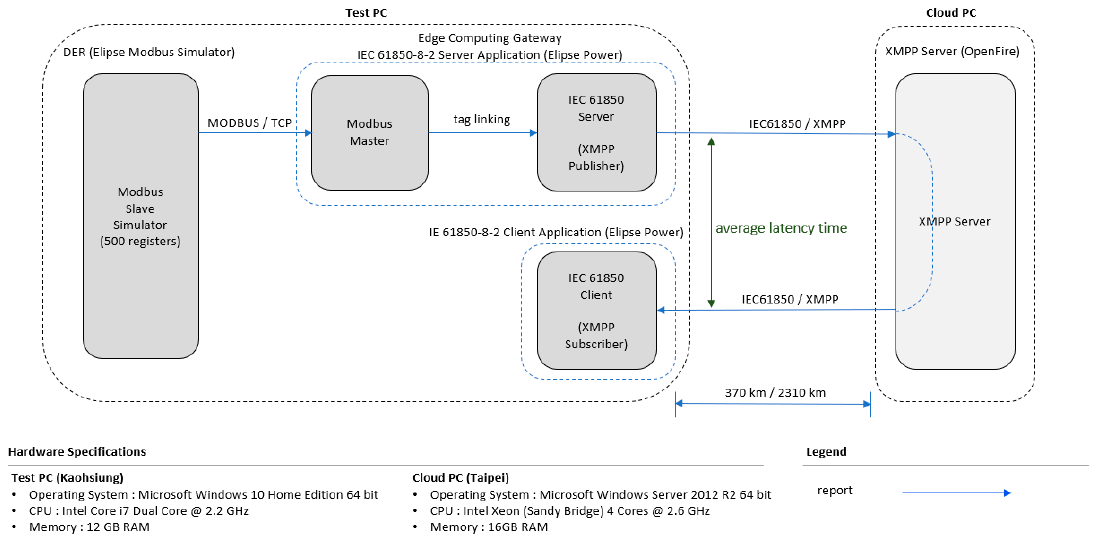
Figure 10. Test environment for latency report test.